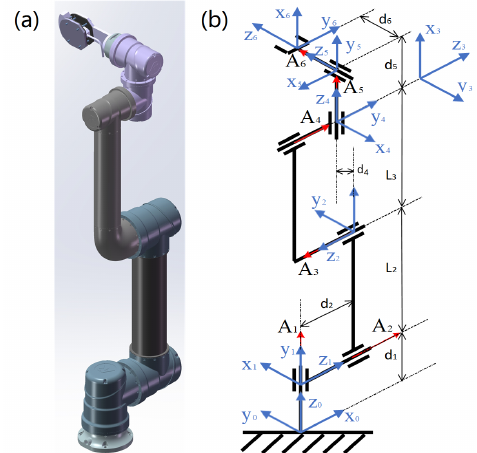
Figure 4. The structure and D-H coordinate system of the scanning arm. ( a ) Scanning arm structure; ( b ) Scanning arm link coordinate system.